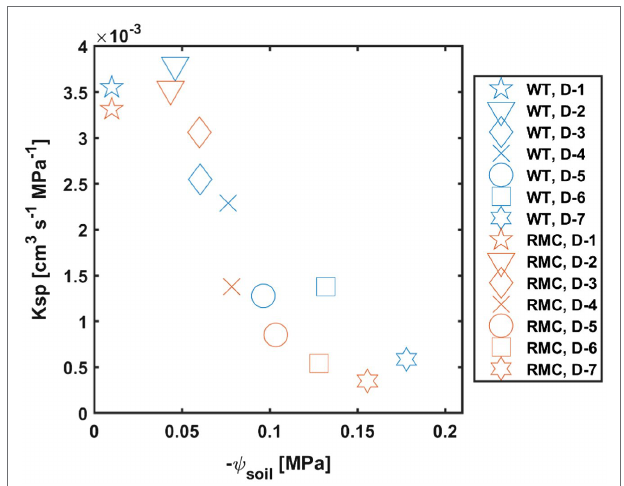
FIGURE 5 | Soil-plant hydraulic conductance ( Ksp ) decreases as soil water potential ( ψ soil ) declines. Plants with mycorrhiza symbiosis (WT) show higher Ksp during soil drying (similar symbols and diverse colors) compare to RMC mutants. D, day after last irrigation. n =